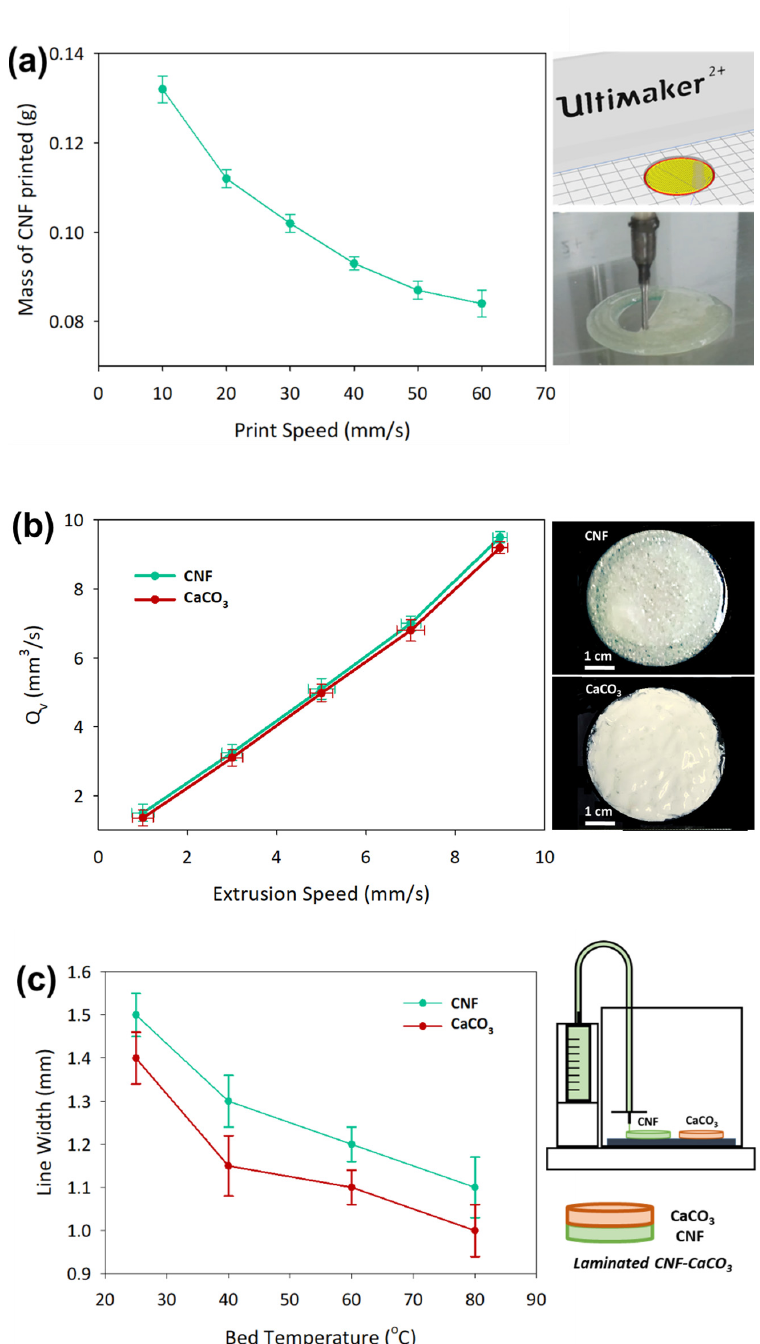
Figure 4. Parameters’ control in preparing 3D printed samples. ( a ) CNF at different printing speeds, ( b ) volumetric flow rates of CNF and CaCO 3 and ( c ) the effect of build plate temperature on the printing line width. The data are presented as mean ± standard deviation ( n = 3).